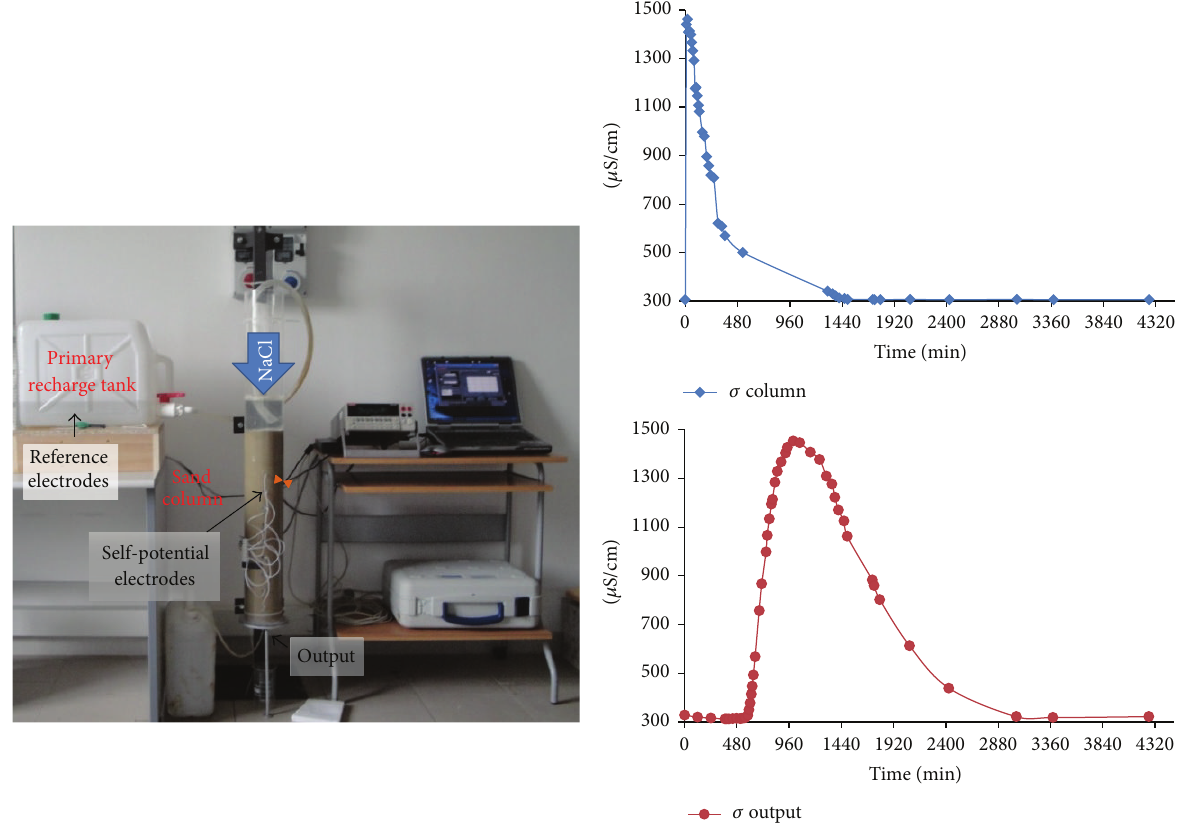
Figure 3: Tracer test experiments: the salt solution was injected at the top of the sand. Water electrical conductivity, monitored both in the column and at the output, shows the tracer behaviour during the